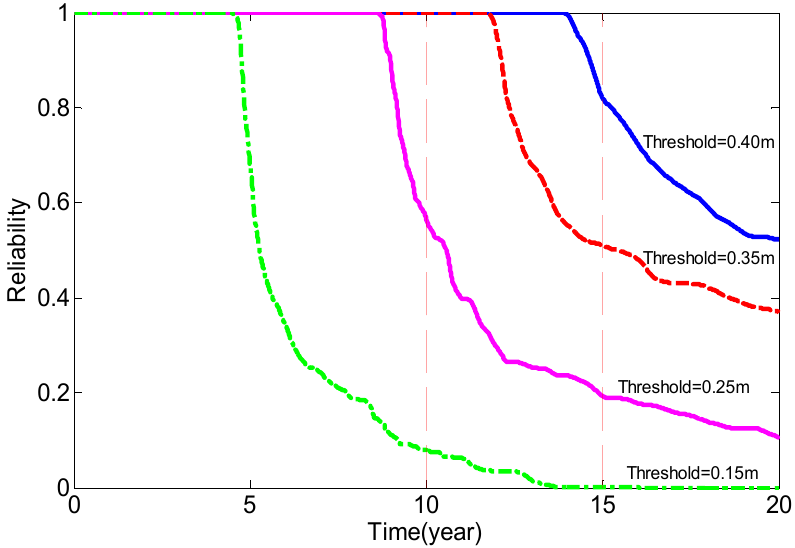
Figure 10. Time-dependent reliability of the long-term settlement deformation of the subway track. Table 3. Time-dependent reliability of the long-term settlement deformation of the subway track. Service Life (years)